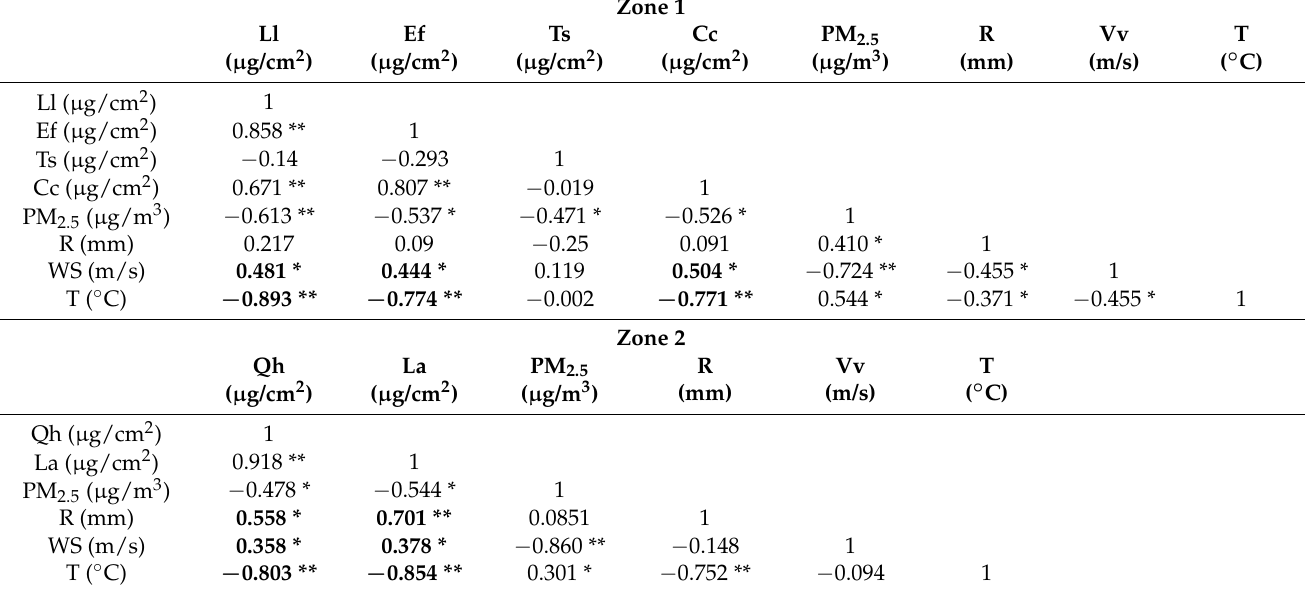
Table 2. Correlation (rs) between IPMCs and climate variables considered. Zone